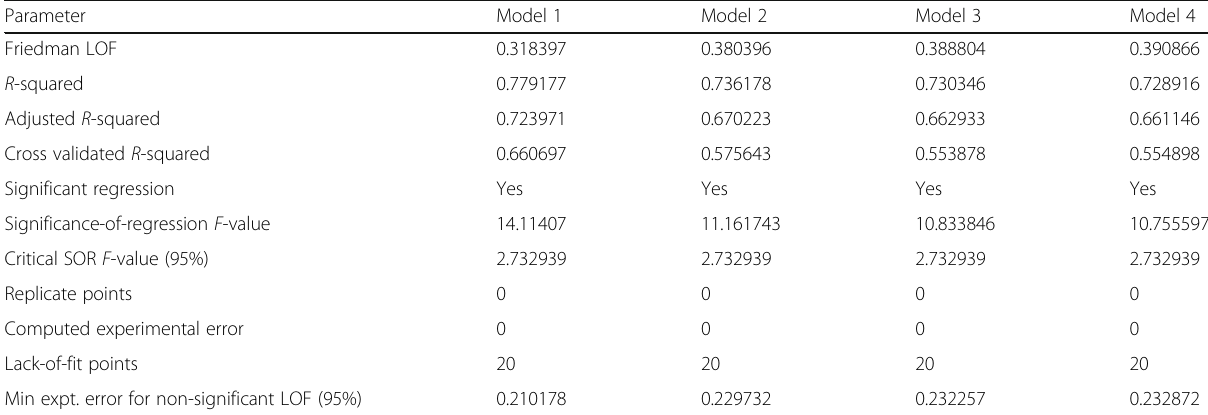
Table 1 Statistical parameters of model 1